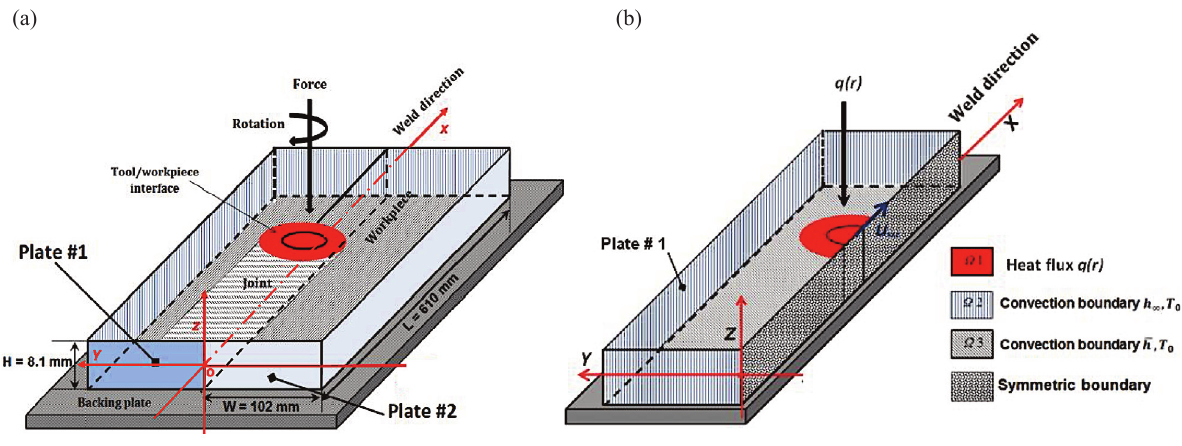
Fig. 2. Applied heat transfer boundary conditions on the computational